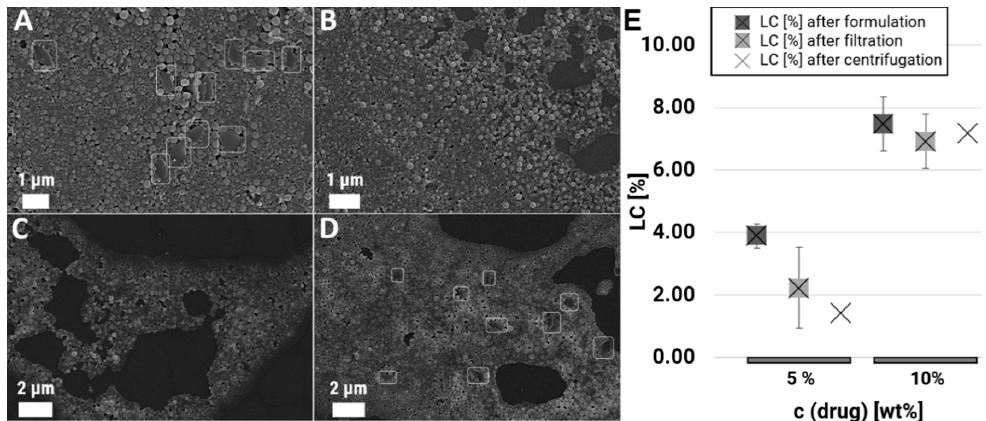
Figure 5. SEM images of the initial sample P15 ( A ) and after removal of the free drug crystals through centrifugation ( B ), 1st filtration ( C ), 2nd filtration ( D ). Influence of the purification method on the loading capacities for P15 and P16 with 5% and 10% ( w / w ) drug feed ( E